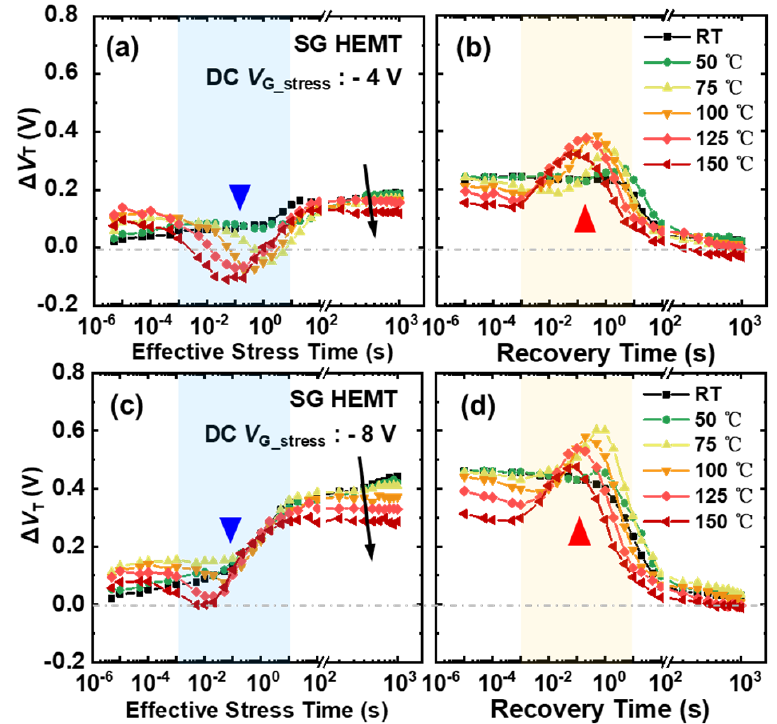
Figure 6. Δ V T evolution of SG HEMT in 1000 s stress and subsequent 1000 s recovery processes under elevated temperature, with gate bias stress at: ( a , b ) − 4 V and ( c , d ) − 8 V.